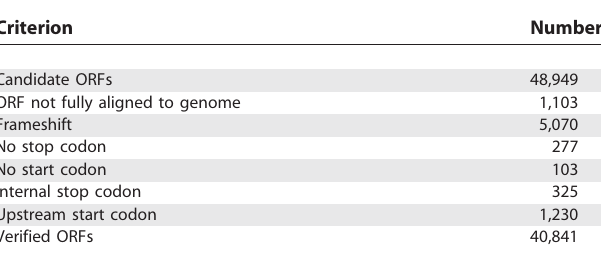
Table 3. Genome-Based ORF